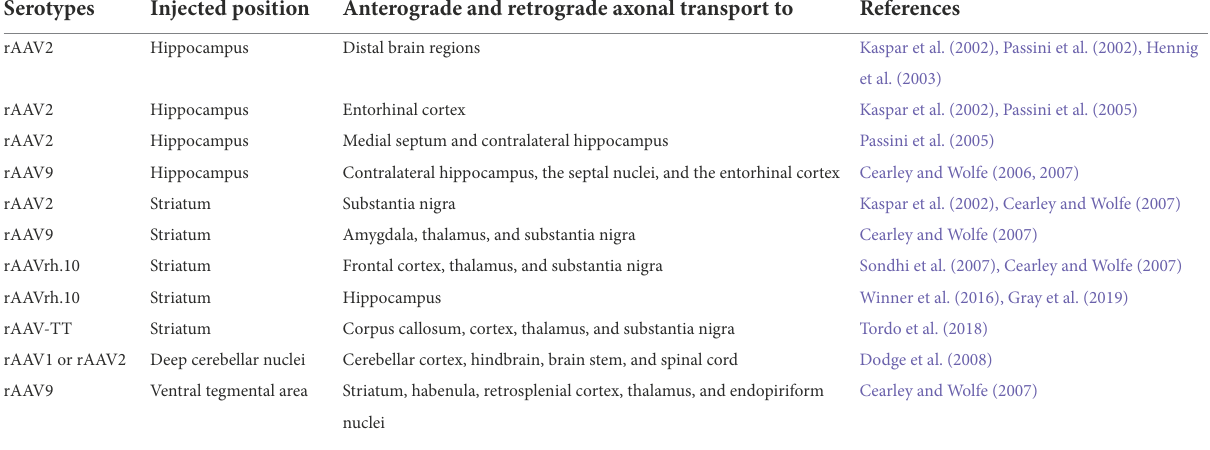
TABLE 1 Anterograde and retrograde axonal transport of various rAAVs in different brain regions.